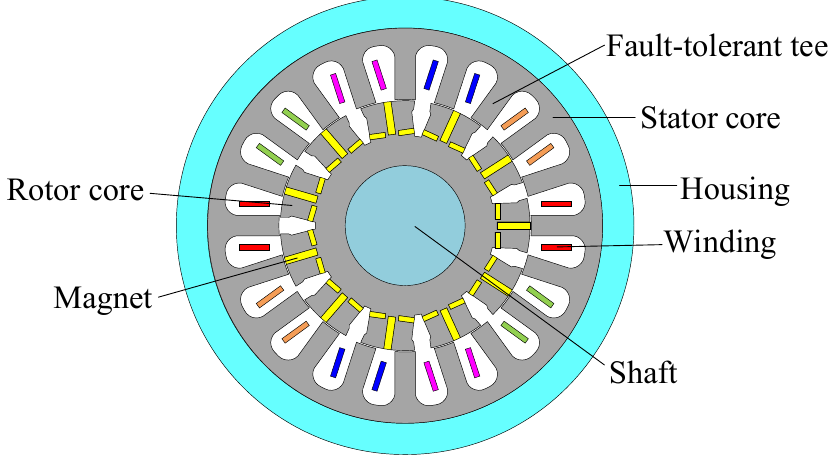
Figure 1. Topological structure of the fault-tolerant flux-switching PM motor.